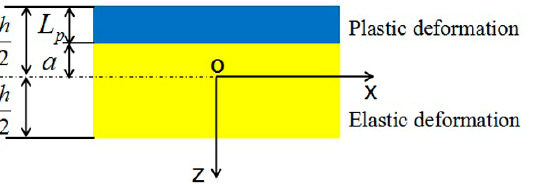
Figure 2. An illustration of deformation scheme for convex bending in laser peen formation.